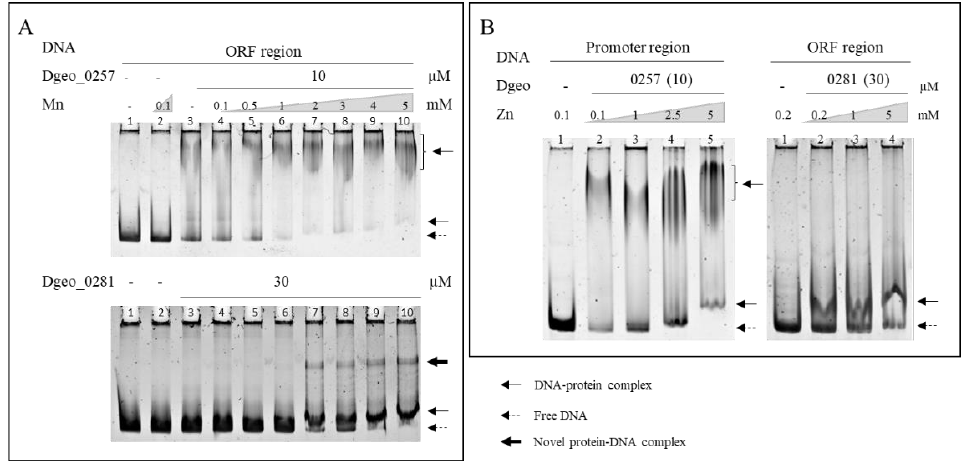
Figure 4. EMSA of Dgeo_0257 and DgDps1 maintaining a protein concentration of 10 µM and 30 µM, respectively, while increasing the metal ion concentration of manganese ( A ) and zinc ( B ).